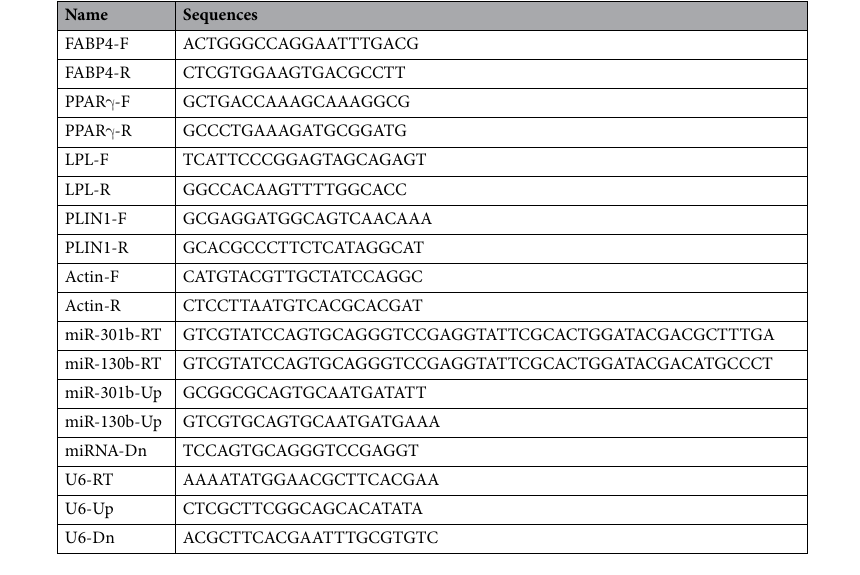
Table 1. Primers used for reverse transcription and